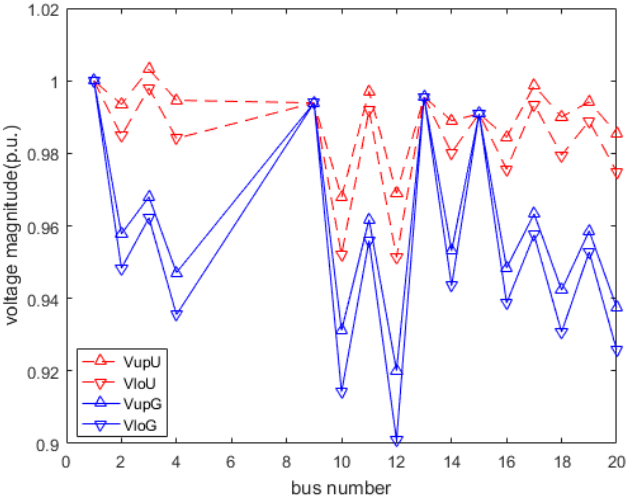
Figure 8. Bus voltage bounds for UCGS and GCGS.